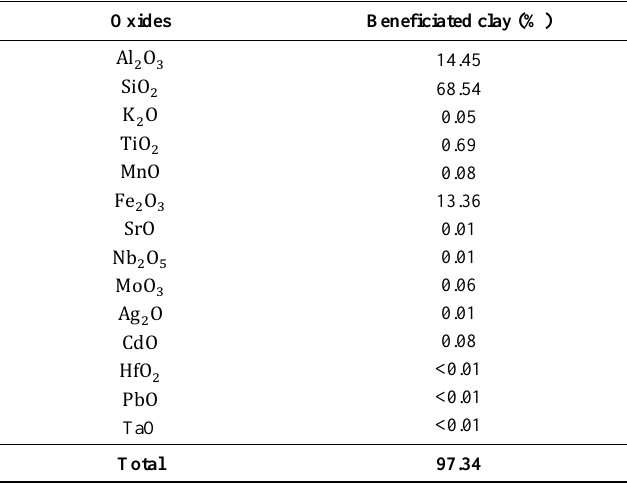
Table 2. X-ray fluorescence spectrometer of the beneficiated local clay Oxides